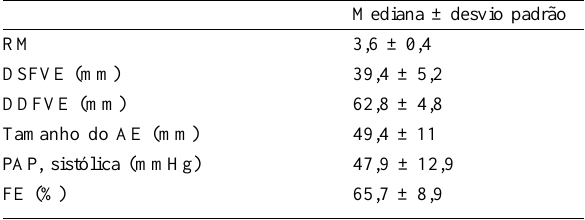
Tabela 2. Dados ecocardiográficos pré-operatórios.